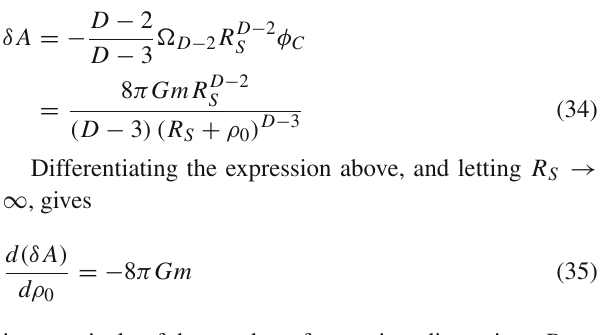
Fig. 1 The initial position of the test mass m. O is the center of the spherical horizon of radius R S of the sphere”, using the mean value theorem in d = D − 1 spatial dimensions. The shift in the horizon area